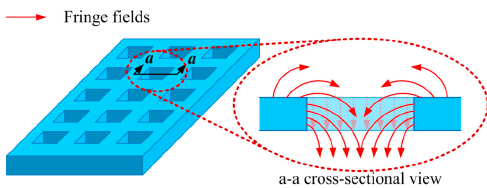
Figure 1. ( a ) The cross-sectional view of a flat-plate capacitor; ( b ) The field lines resulted by a bias voltage V , where b , g , h and ε are width, gap, thickness and permittivity of dielectric, respectively.